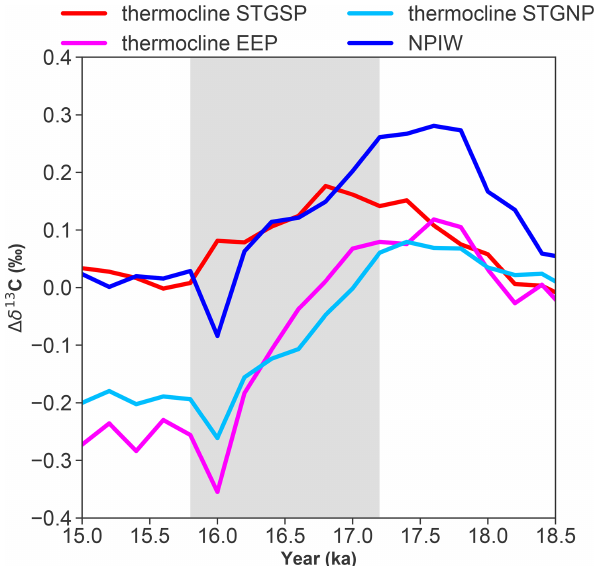
Figure 7. LOVECLIM-simulated (cid:49)δ 13 C in thermocline the EEP (90–82 ◦ W, 5 ◦ S–5 ◦ N; 77–105m), South Pacific subtropical gyre (STGSP; 160 ◦ E–100 ◦ W, 40–22 ◦ S; 187–400m), North Pacific subtropical gyre (STGNP; 110 ◦ E–140 ◦ W, 22–40 ◦ N; 187–400m), and NPIW (167–170 ◦ E, 54–57 ◦ N; 660m). The average of 23.8– 20ka (i.e., LGM) is used as a reference level for the (cid:49)δ 13 C calcu- lations. The interval of decreasing δ 13 C is highlighted with a grey bar.